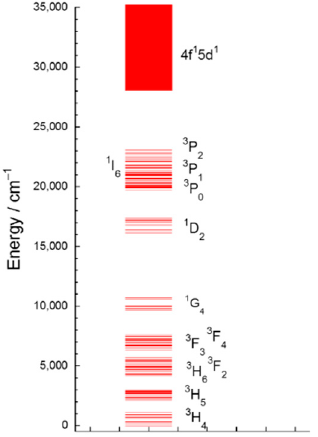
Figure 10. Energy level diagram below 35,000 cm − 1 of Pr 3 + -doped Y 2 O 3 obtained from the absorption and emission spectra.